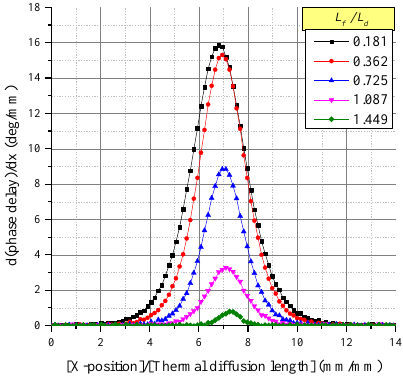
Figure 10. Performance of line-spread function (LSF) with changes in L f / L d . Table 4. Spatial resolution and contrast depending on the change according to L f / L d ( R b was fixed to 100 µ m, R b / L d = 0.145).